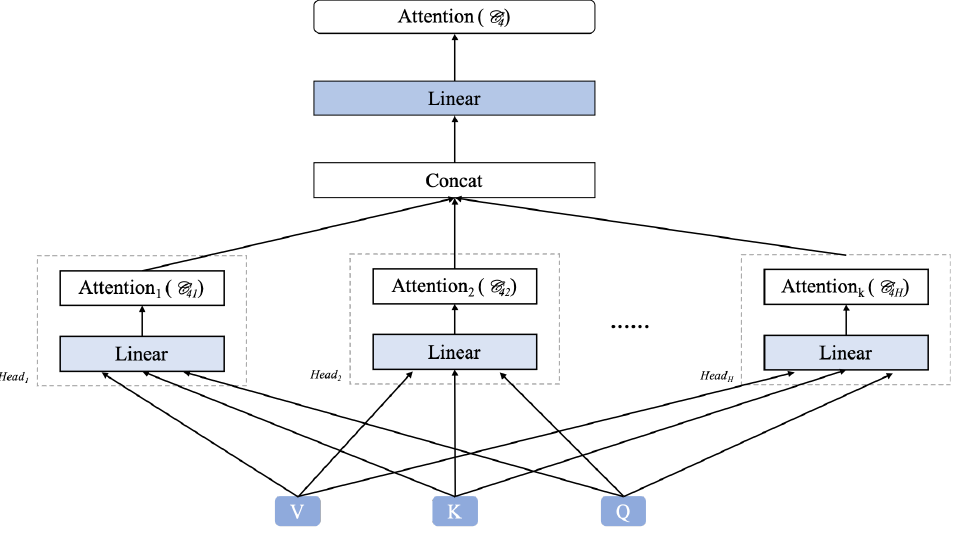
Figure 3. Multi-head Attention Mechanism for Capturing Context C 4